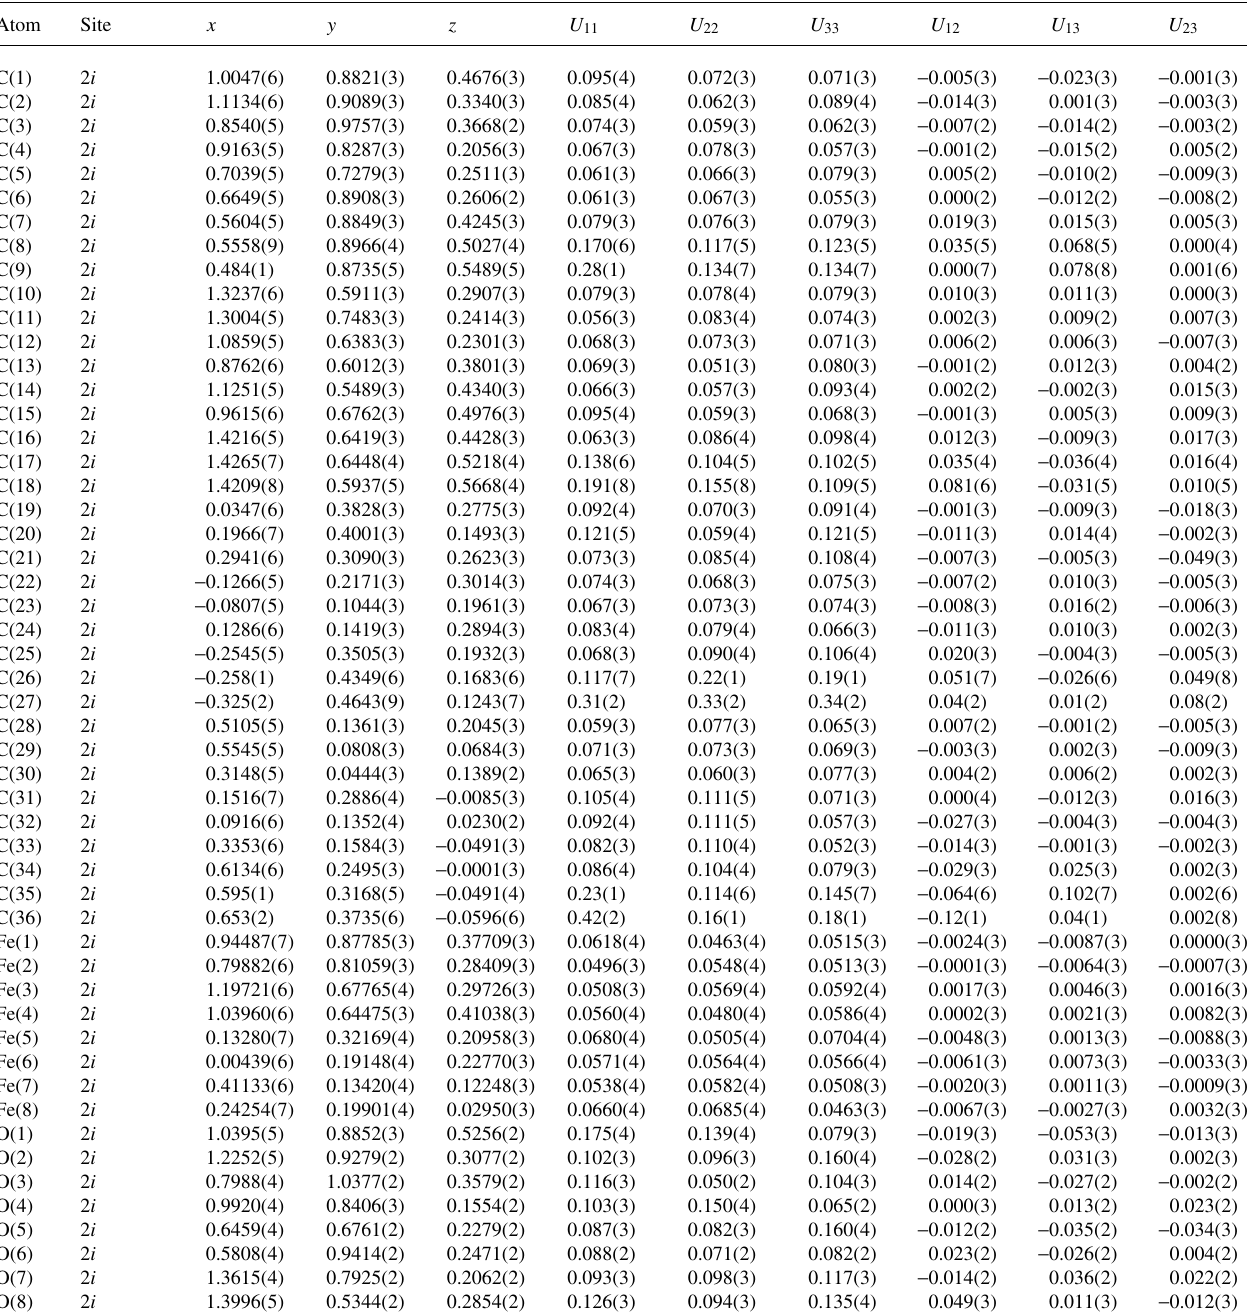
Table 3. Atomic coordinates and displacement parameters (in Å 2 ) .